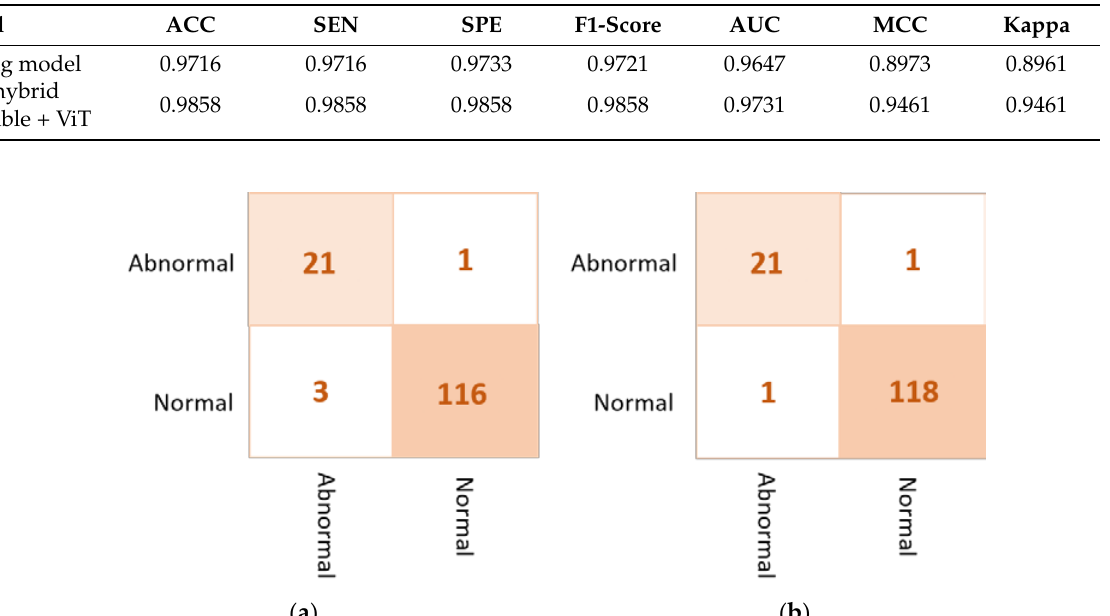
Figure 8. Evaluation performance in terms of the confusion matrices of the proposed AI models. ( a ) Ensemble learning as a backbone model and ( b ) the proposed AI-based ETECADx model.